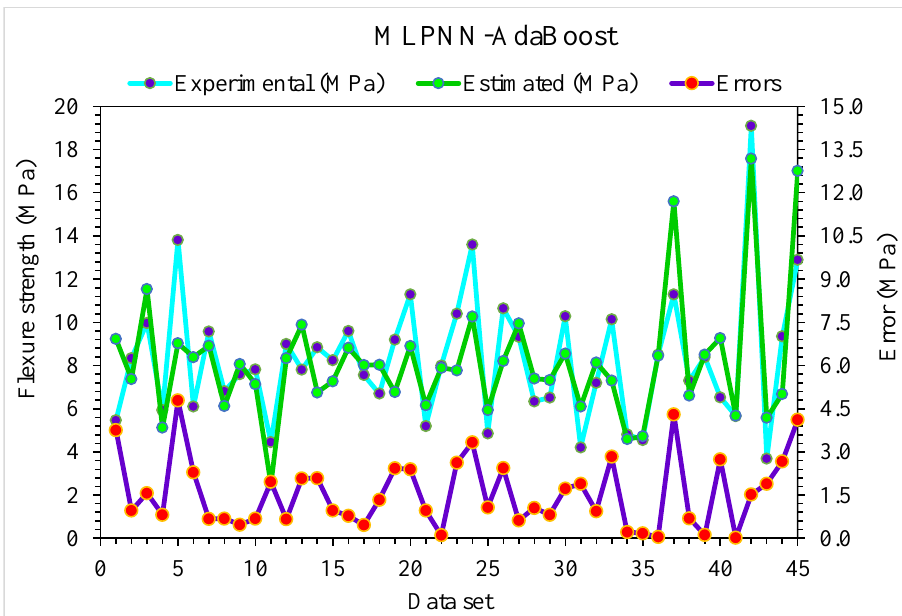
Figure 11. Experimental and MLPNN-AdaBoost predicted values with errors for flexural strength.